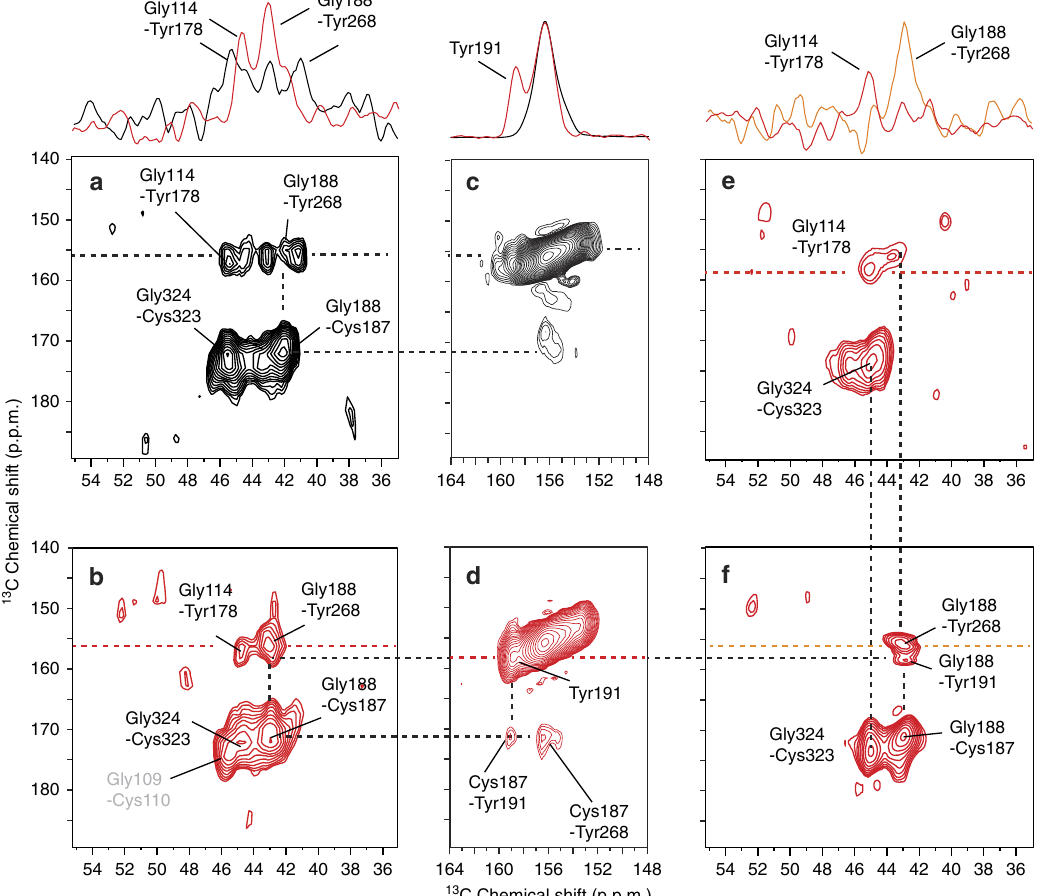
Figure 2 | Tyr268 6.51 to Gly188 EL2 and Tyr268 6.51 to Cys187 EL2 contacts in Meta-II. ( a ) 2D DARR spectrum highlighting Tyr-Gly contacts in rhodopsin using rhodopsin containing 13 C z -Tyr, 13 C a -Gly and 13 C ¼ O-Cys. In the rhodopsin crystal structure (PDB-ID 1U19; ref. 26), there are six Tyr(C z )-Gly(C a ) contacts, which are all located in the extracellular region of rhodopsin. These contacts involve five tyrosines and five glycines: Tyr10 N (cid:2) term -Gly3 N (cid:2) term , 5.3Å. Above a are shown rows through the Tyr-Gly crosspeaks. The rows better illustrate the intensity change occurring in the Tyr268 6.51 -Gly188 EL2 peak on activation. The observation that the Tyr178 EL2 -Gly114 3.29 crosspeak does not change intensity is consistent with the lack of influence of the Y178F mutation on the Meta-I–Meta-II transition (Fig. 4g). ( b ) Wild-type Meta-II spectrum using rhodopsin containing 13 C z -Tyr, 13 C a -Gly and 13 C ¼ O-Cys. ( c , d ) Region of the 2D DARR spectra of rhodopsin (black) and Meta-II (red) corresponding to 13 C z -Tyr to 13 C ¼ O-Cys crosspeaks. Above c are shown rows through the 13 C z -Tyr diagonal of rhodopsin and Meta-II. ( e , f ) G188A Meta-II and Y178F Meta-II spectra, respectively, using the same 13 C-labelling scheme as above. Rows are shown through the Tyr-Gly crosspeaks in the G188A Meta-II and Y178F Meta-II spectra above e